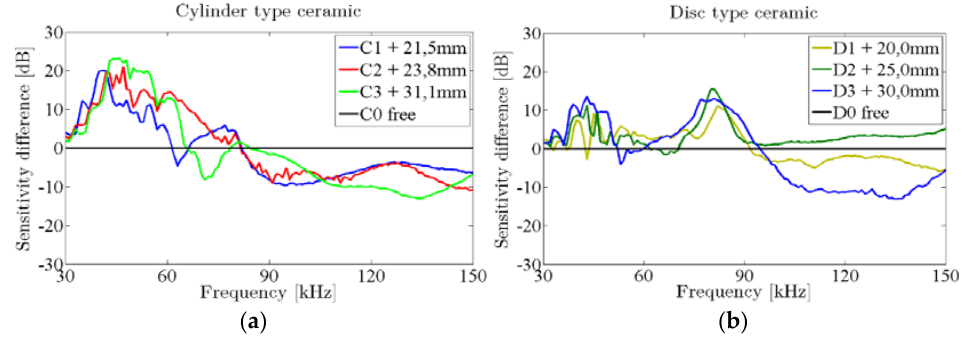
Figure 11. Sensitivity difference of ceramics with ML (color lines) with respect to the one without ML (black line), measured in the water tank. The statistical uncertainties are quite similar to those shown in Figure 9. The estimated systematic uncertainty due to reproducibility is 3 dB. ( a ) Cylinder type ceramic; ( b ) Disc type ceramic.